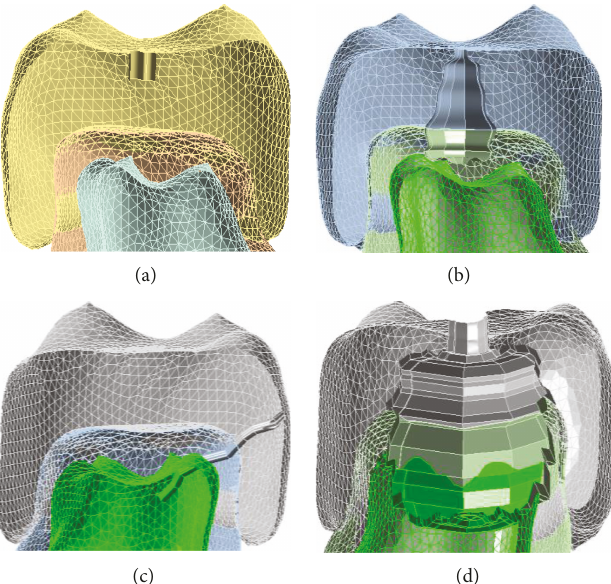
Figure 4: Biomodels with the four degrees of decay, based on (a) fi rst grade, (b) second grade, (c) third grade, and (d) fourth